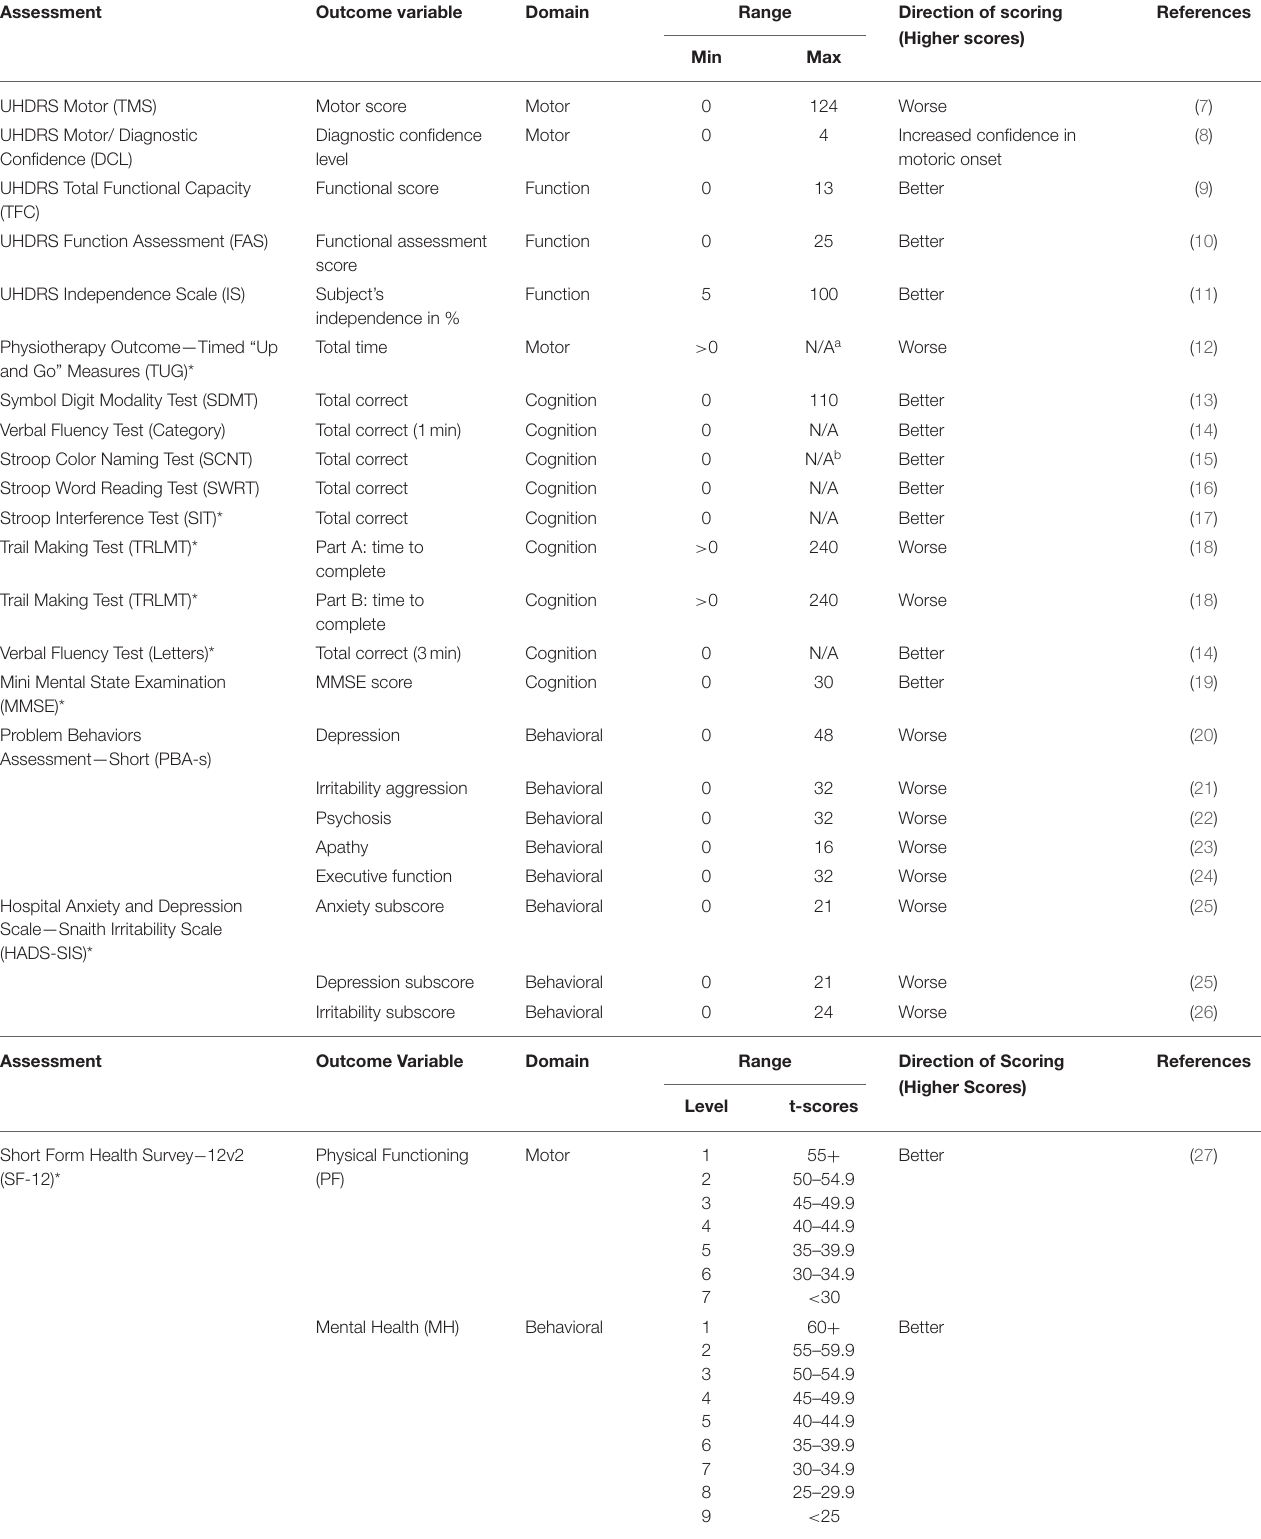
TABLE 2 | Clinical assessments and outcome measures.